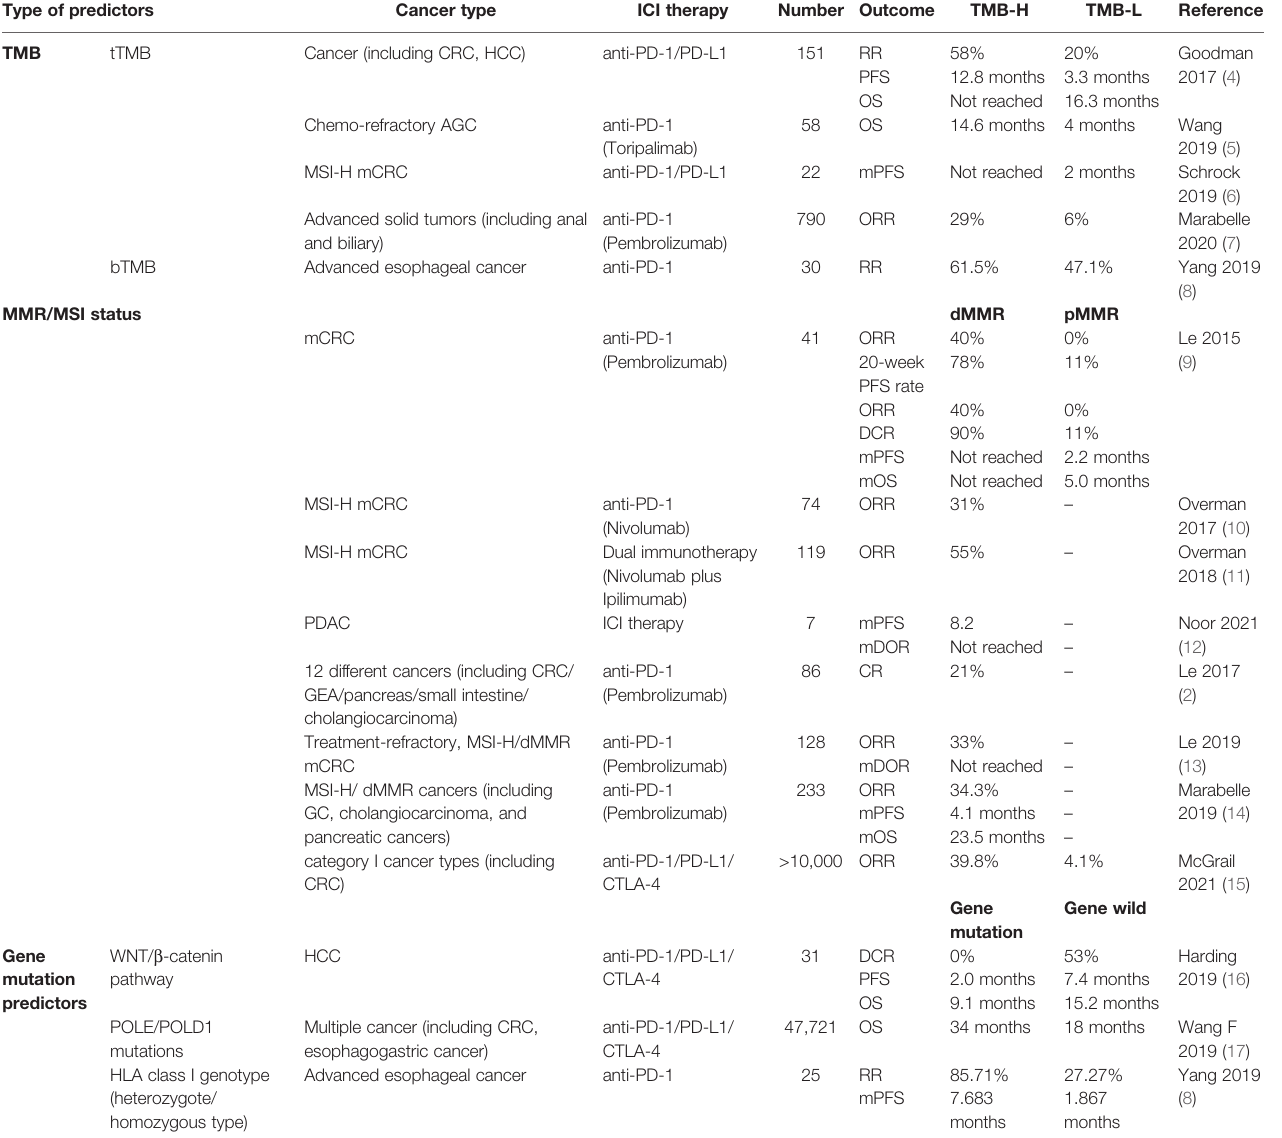
TABLE 1 | Predictive ability of tumor genome-related biomarkers for response to ICI therapy for digestive system